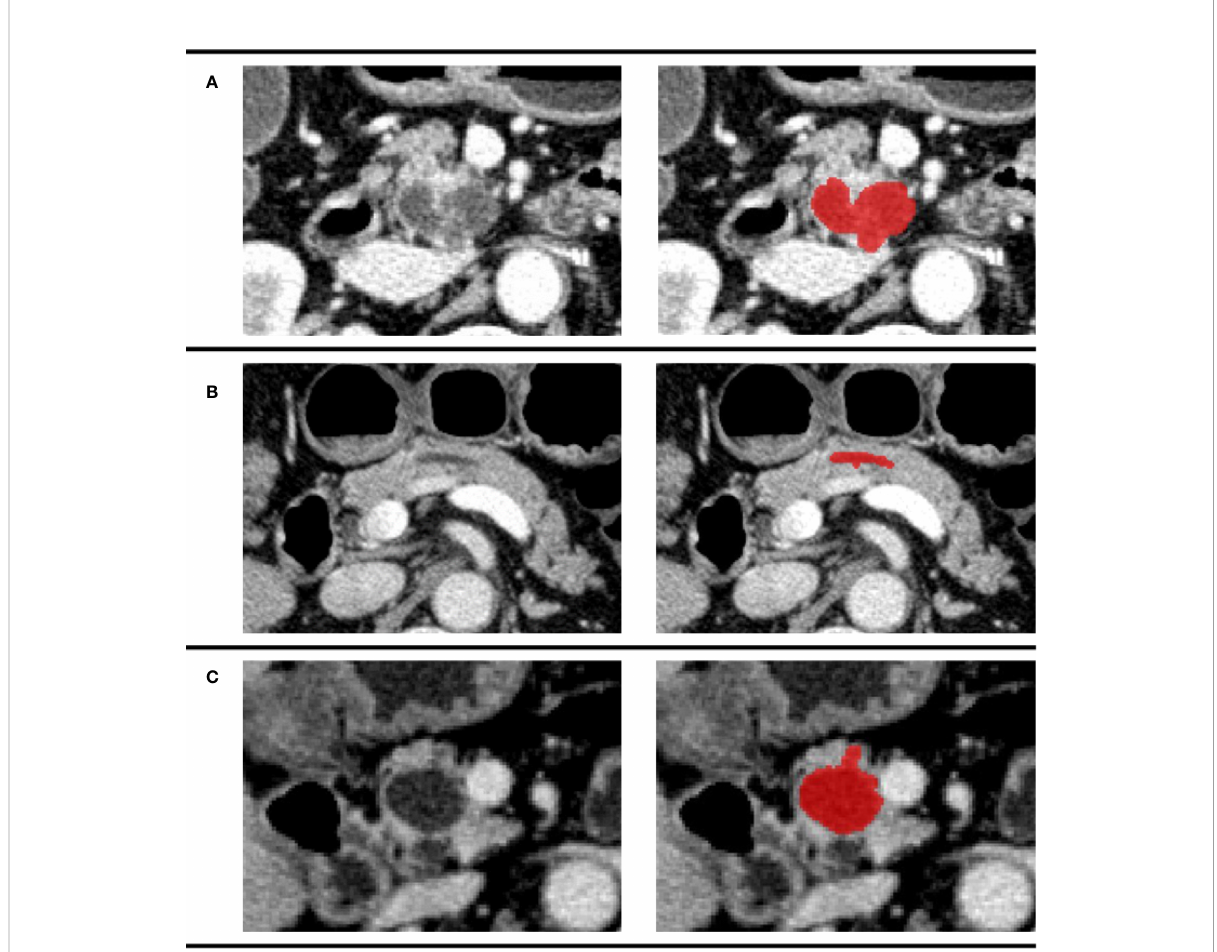
FIGURE 3 Examples of different patients in the venous phase. Tumor regions were drawn with red. (A) CECT image of a 74-year-old man pathologically diagnosed with IPMN; (B) CECT image of a 61-year-old woman pathologically diagnosed with SCN; (C) CECT image of a 70-year-old man pathologically diagnosed with